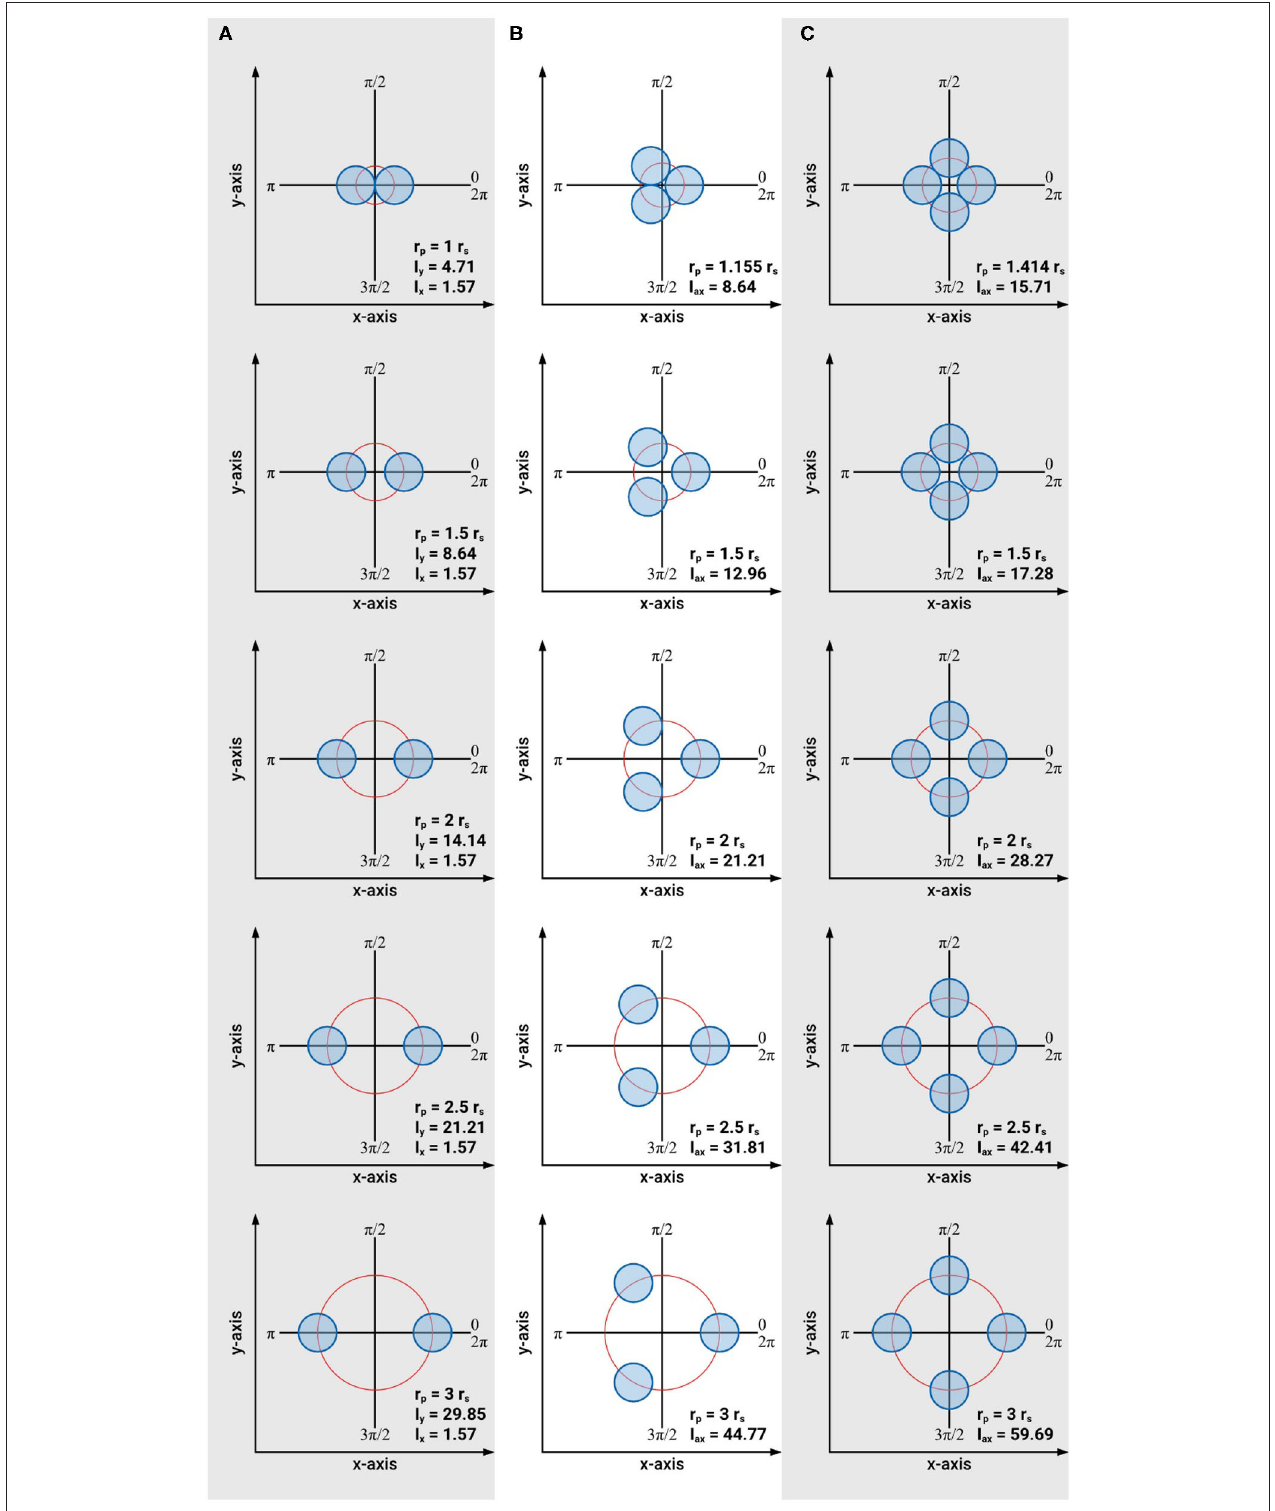
FIGURE 7 | Schematic of the arrangements of intertwined braided stems consisting of one to four individual stems used to calculate axial second moments of area and braiding efficiency. (A) Arrangement of two intertwined stems with r s = 1 = const. and A = 6.28 = const., (B) arrangement of three intertwined stems with r s = 1 = const. and A = 9.42 = const., (C) arrangement of four intertwined stems with r s = 1 = const. and A = 12.57 = const.